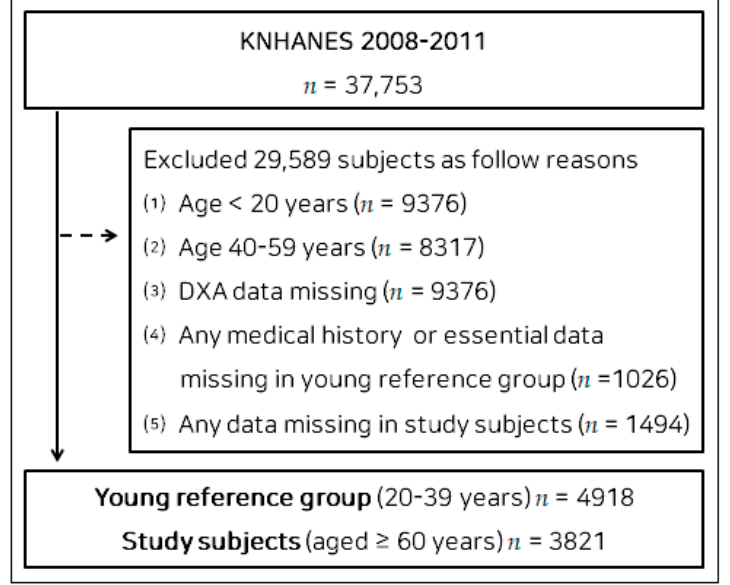
Figure 1. Flow diagram of participant enrollment. Abbreviations: KNHANES, Korea National Health and Nutritional Examination Survey; DXA, Dual X-ray